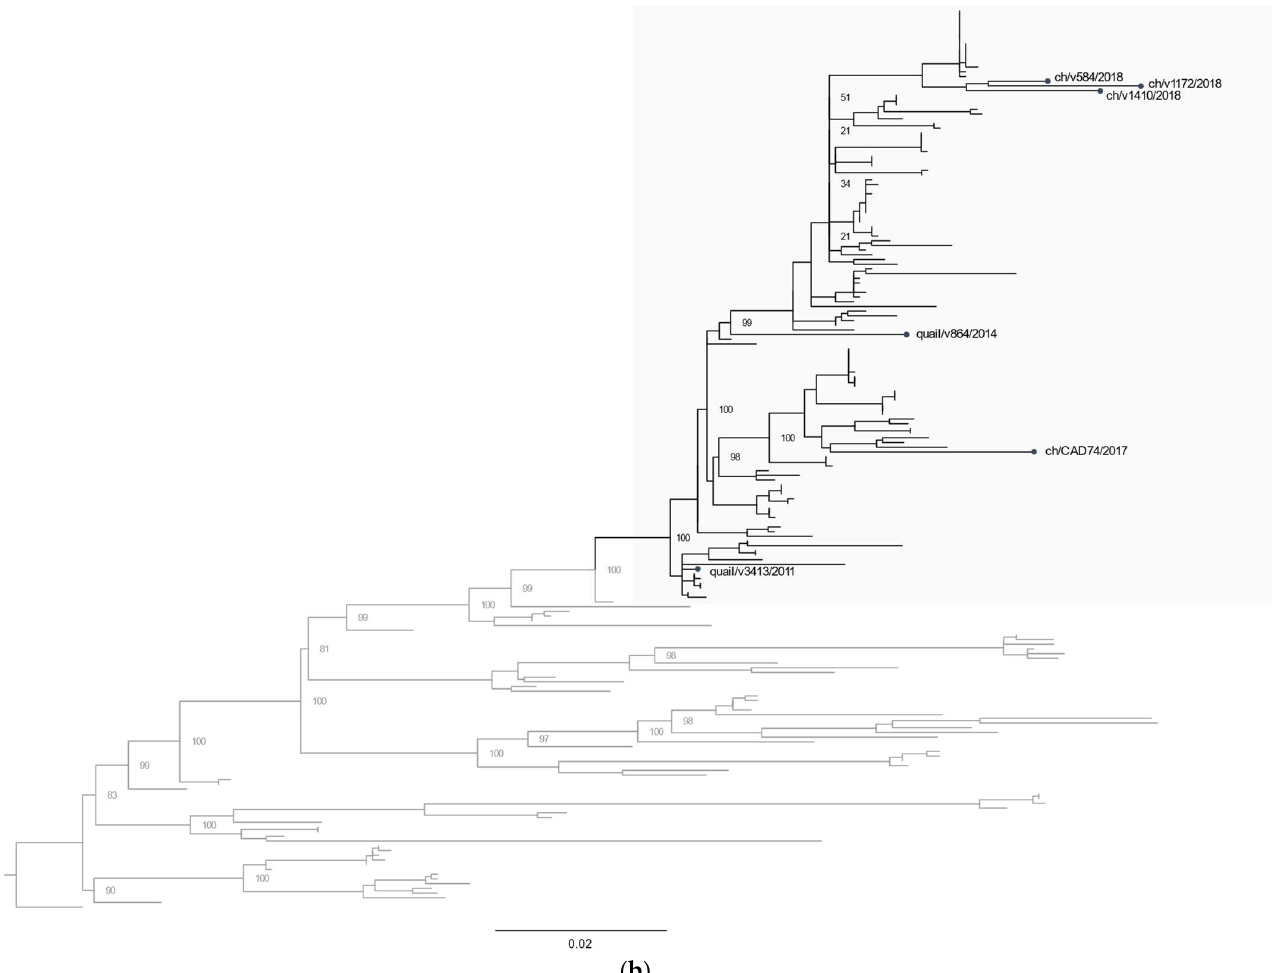
Figure 2 . Phylogenetic trees of the nucleotide sequences of the HA ( a ) and NA ( b ) gene segments. The whole HA ( a ) and NA ( b ) gene segment were used from viruses reported till October 2021 and available at NCBI. Maximum likelihood calculations were done using the IQTree software under the best fit model, according to the Bayesian criterion. Egyptian LPAIV H9N2 virus variants are grey-shaded. Virus strains sequenced in this study are indicated by a black dot.